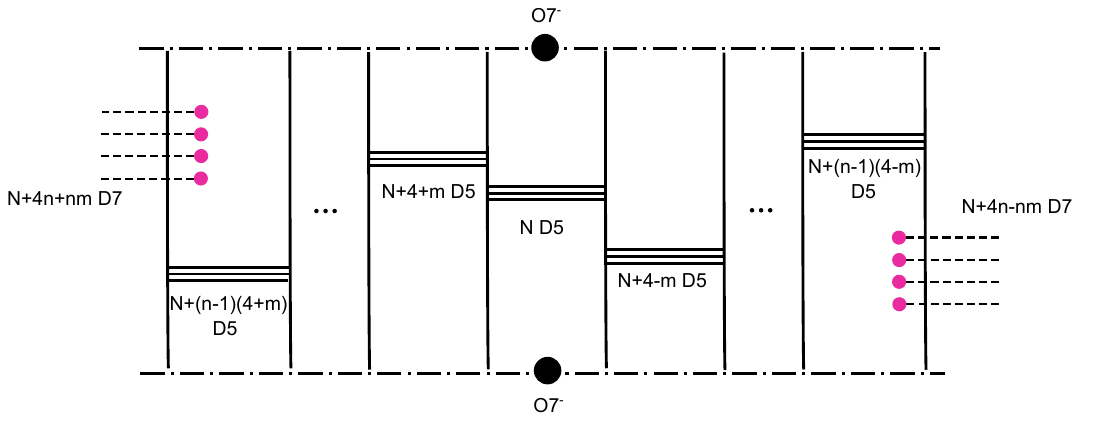
Figure 23 . Type IIB brane con(cid:12)guration after performing a T-duality to (cid:12)gure